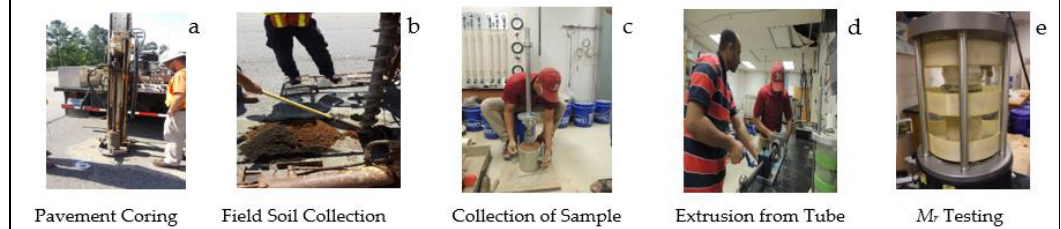
Figure 2. Soil collection and laboratory testing.